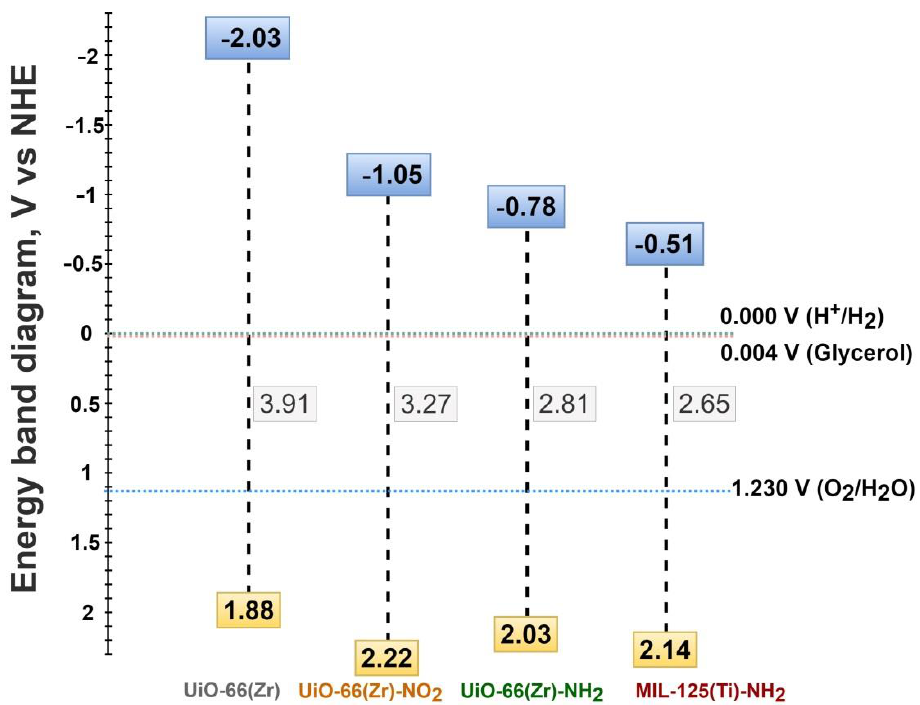
Figure 4. Energy band diagram for UiO-66(Zr)-H, UiO-66(Zr)-NO 2 , UiO-66(Zr)-NH 2 and MIL-125(Ti)-NH 2 . The proton and oxygen reduction and glycerol oxidation potentials are also indicated.